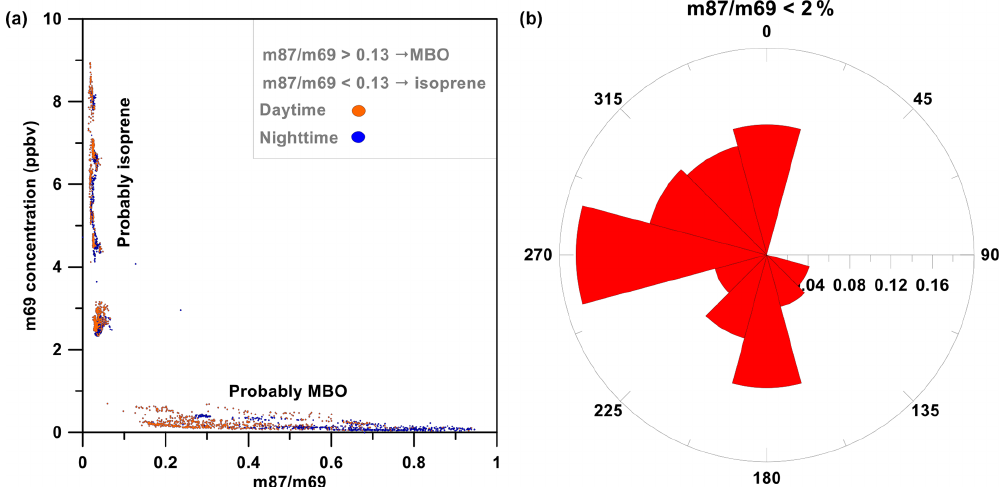
Figure 5. Isoprene and MBO ∗ origins. (a) Scatter plot of m69 mixing ratios as a function of the m87 / m69 ratio. Low and high ratios indicate a predominant contribution of MBO ∗ (see definition in Sect. 3.2.1) and isoprene, respectively. The orange dots were measured during the daytime and the dark blue dots during the night. (b) Fraction of time for each wind sector for which m87 / m69 was less than